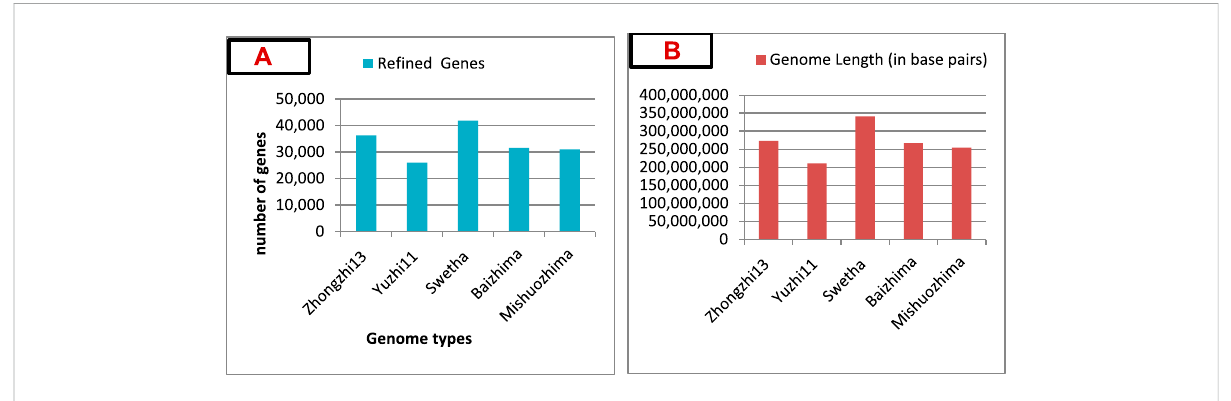
FIGURE 2 (A) Genomessequencedandtheirre fi nednumberofgenes. (B) Genomelengths(inbasepairs)of fi vecultivars(genomes).Datasource:Yuetal.